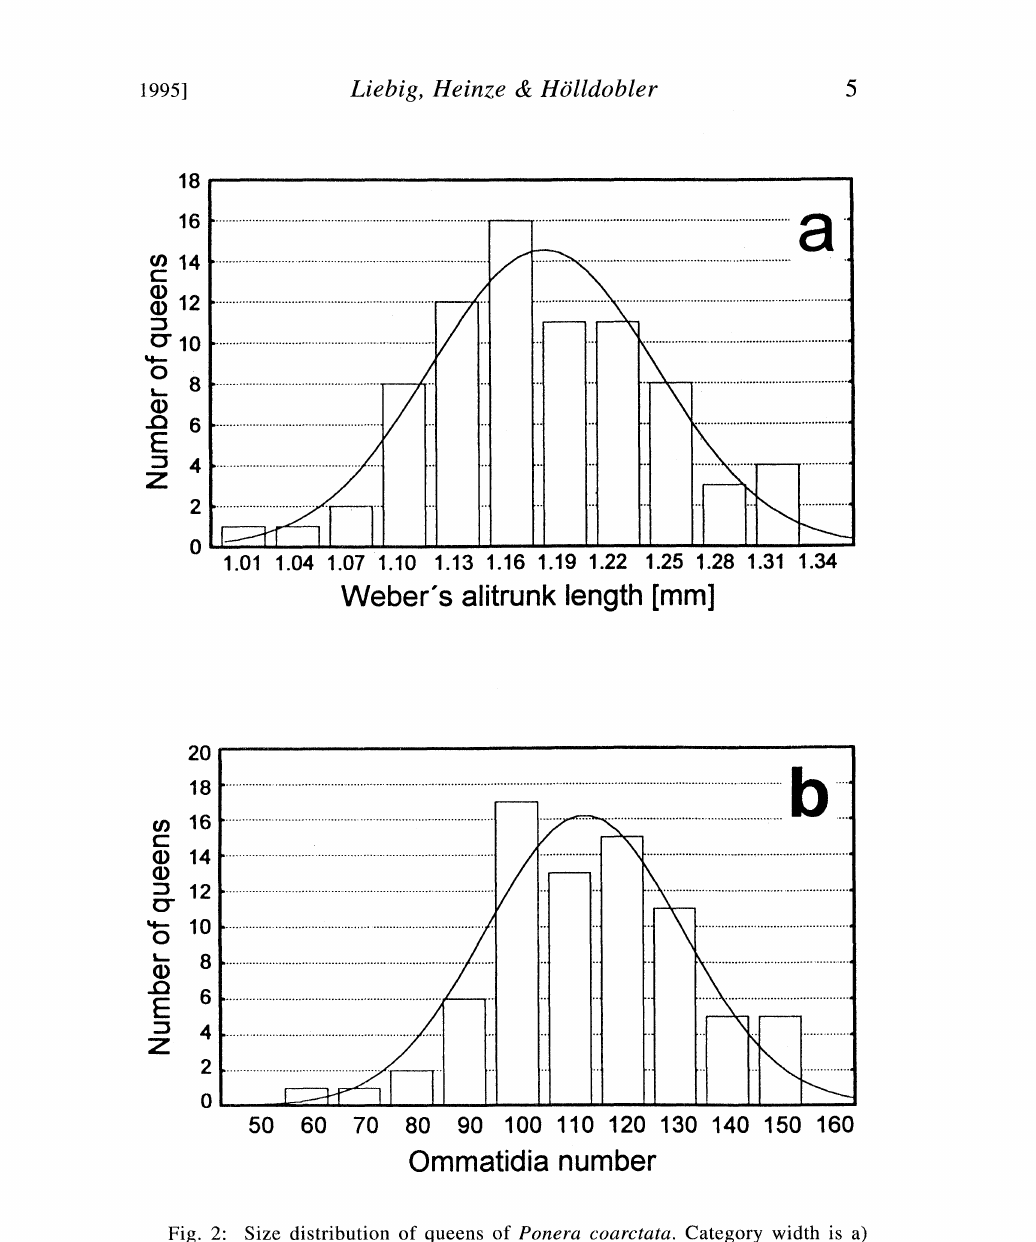
Fig. 2: Size distribution of queens of Ponera coarctata. Category width is a) 0.03mm for WL (n 77) and b) 10 ommatidia for the number of ommatidia per eye (n 76). Numbers refer to the upper limit of the categories. The superimposed curve indicates a normal distribution fitted, to the